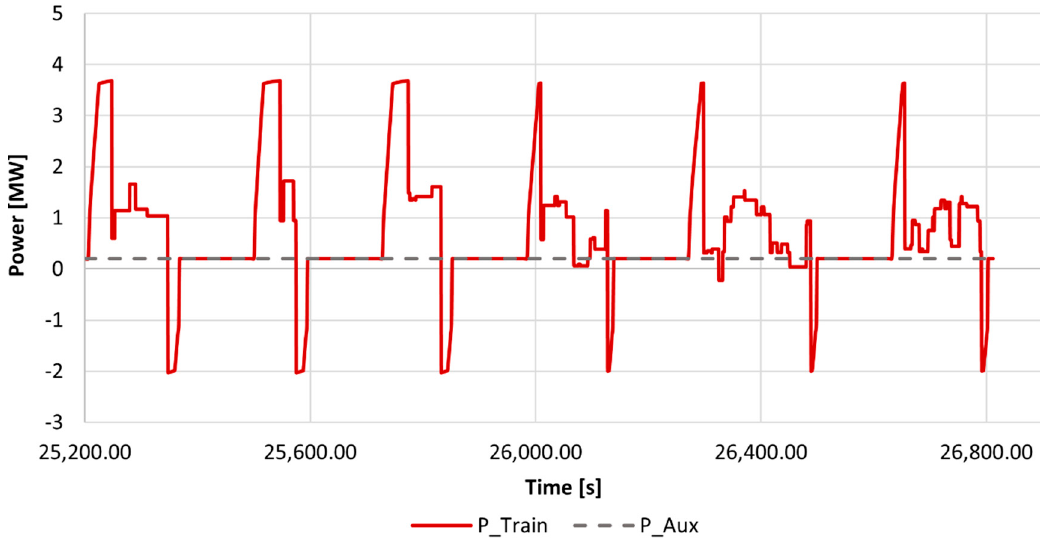
Figure 12. Power profile from Station A to Station B.